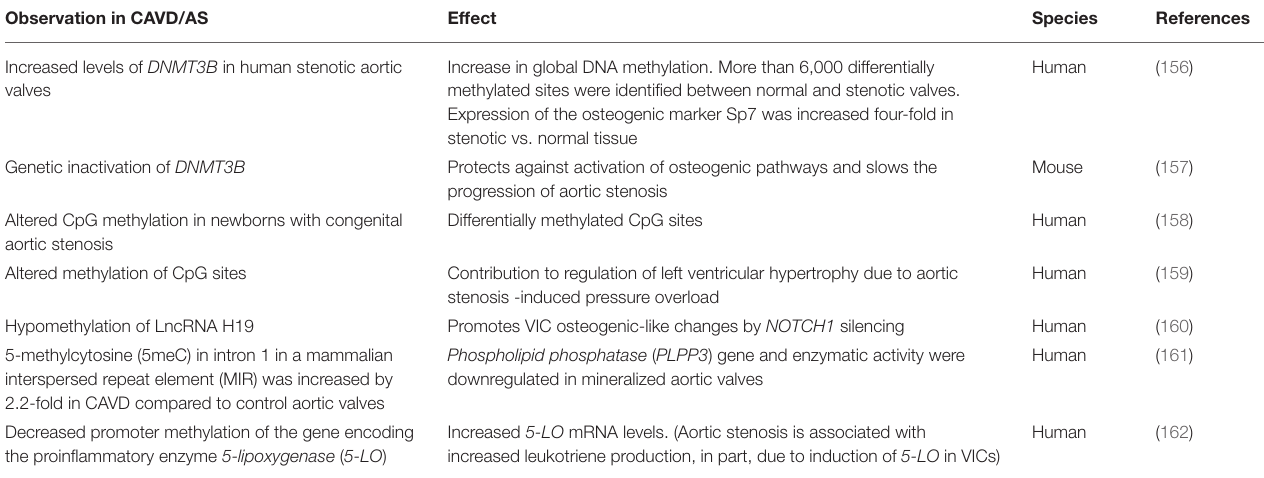
TABLE 1 | The Role of DNA methylation in CAVD/Aortic Stenosis. Observation in